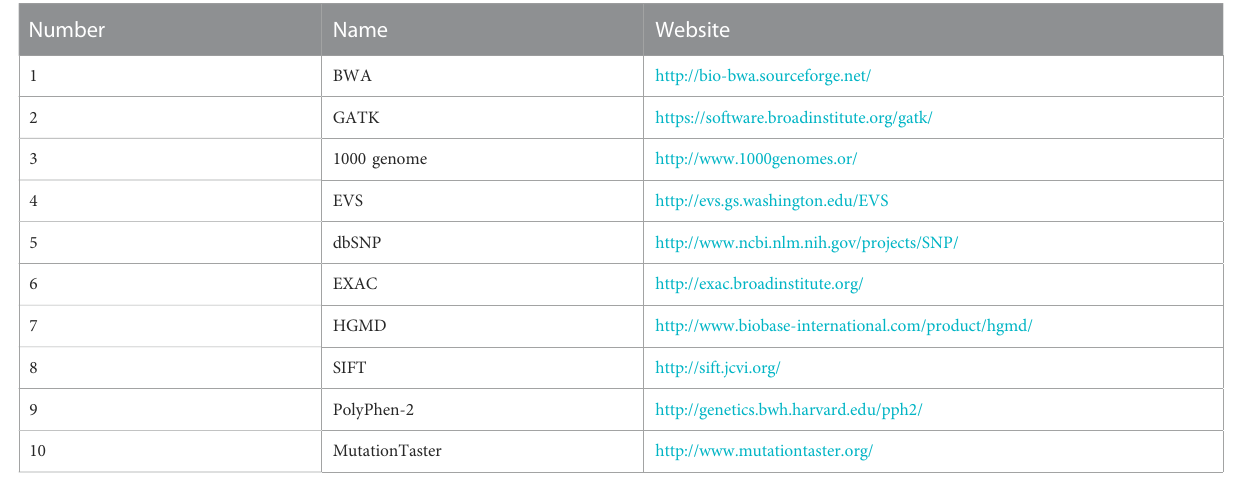
TABLE 1 Software and